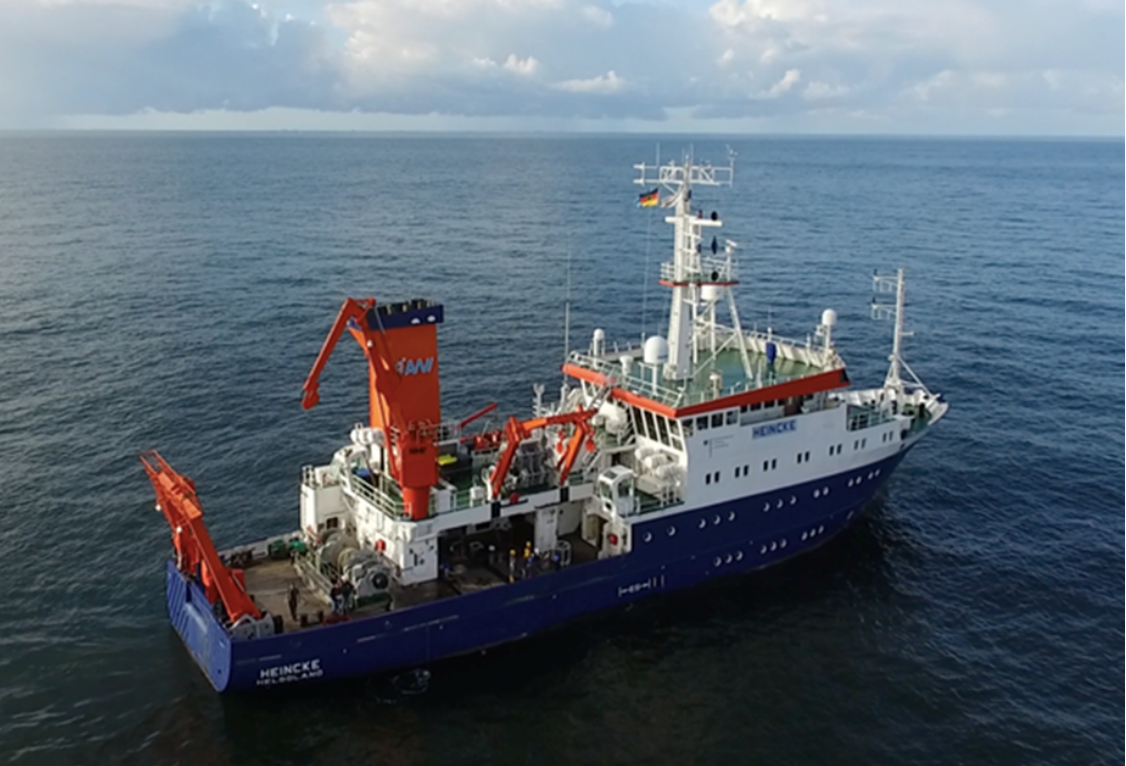
Figure 1: Heincke working at sea. Photo: AWI /